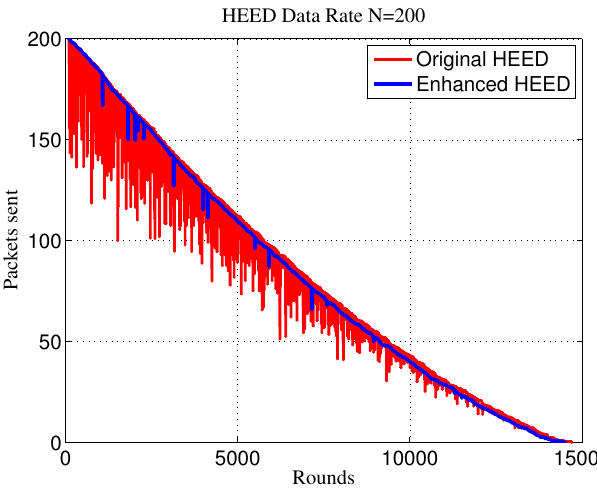
Figure 11. Data Rate of Original HEED vs Enhanced HEED without EH